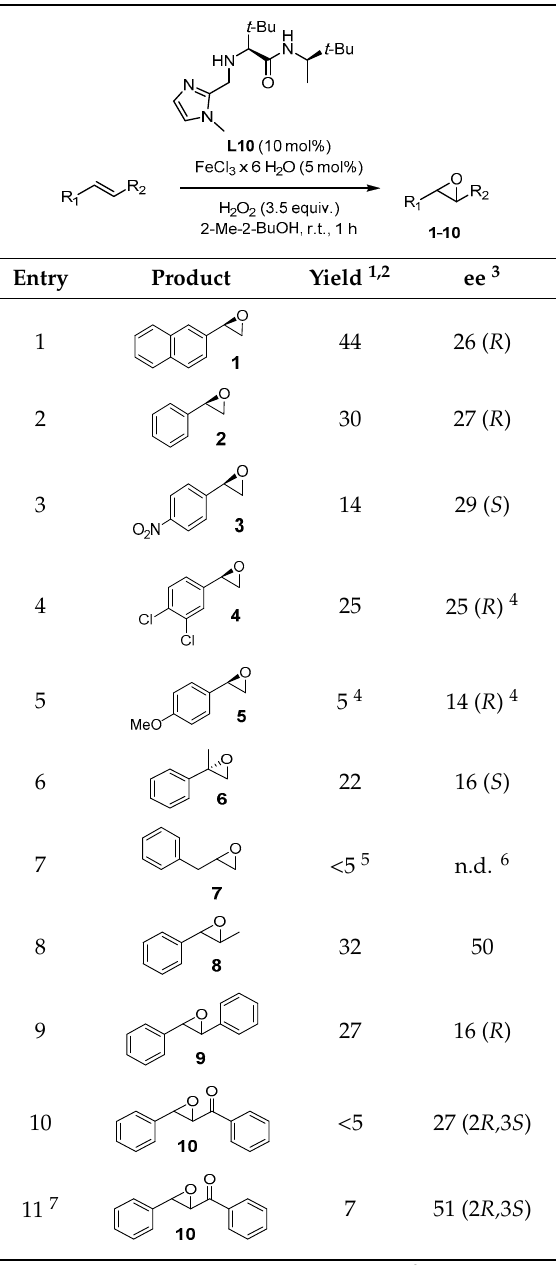
Table 2. Screening of